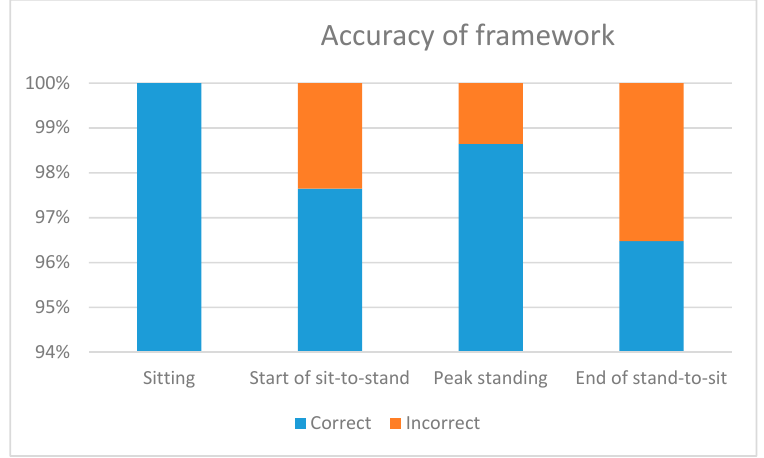
Figure 5. Classification results for each phase. Correct classifications versus incorrect classifications. Table 2. Transition detection rates for each point of interest.